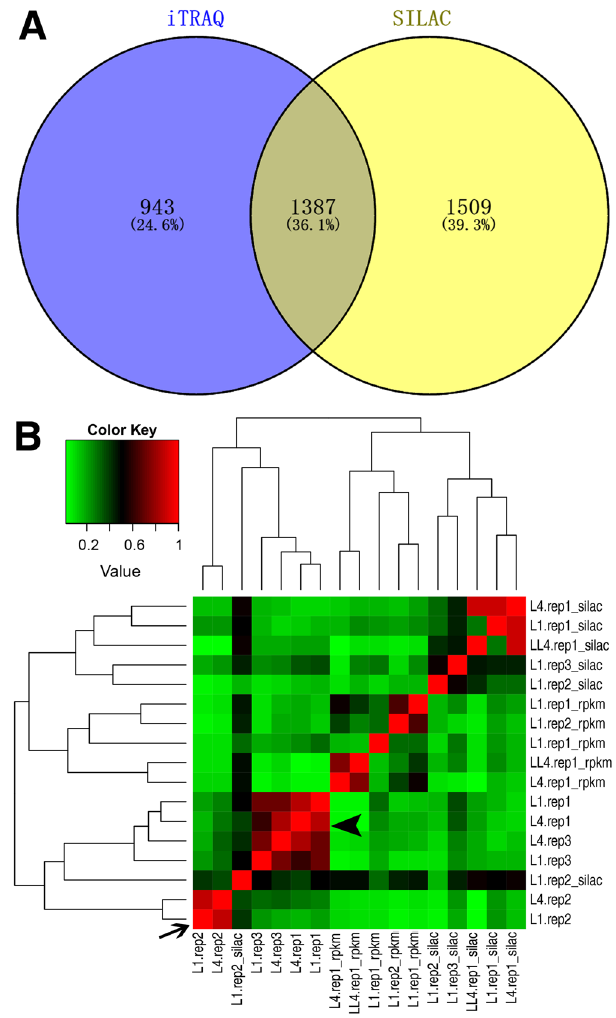
Figure 2. Comparison of C. briggsae proteomes identified by iTRAQ in this study and those by SILAC in a previous study 29 . ( A ) Venn diagram showing the total number of proteins identified by iTRAQ (blue) or SILAC (yellow) in all three replicates of L1 and L4 larval stages. Note only about a third of the proteomes is shared between the two methods. ( B ) A heat map showing the correlation of fold changes of the proteins/transcripts in larval stages versus embryonic stages identified by iTRAQ or SILAC. Protein or transcript samples measured in the previous study are indicated with “silac” or “rpkm”, respectively. Correlations of fold changes detected by iTRAQ between L1 and L4 stages are indicated with an arrowhead or an arrow for replicates 1 and 3 or replicate 2,